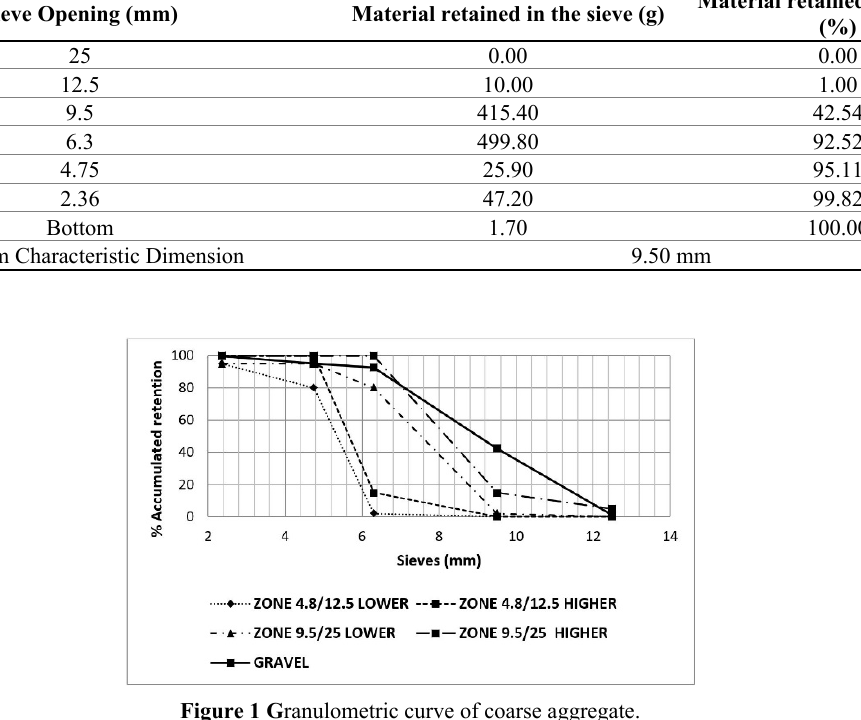
Figure 1 G ranulometric curve of coarse